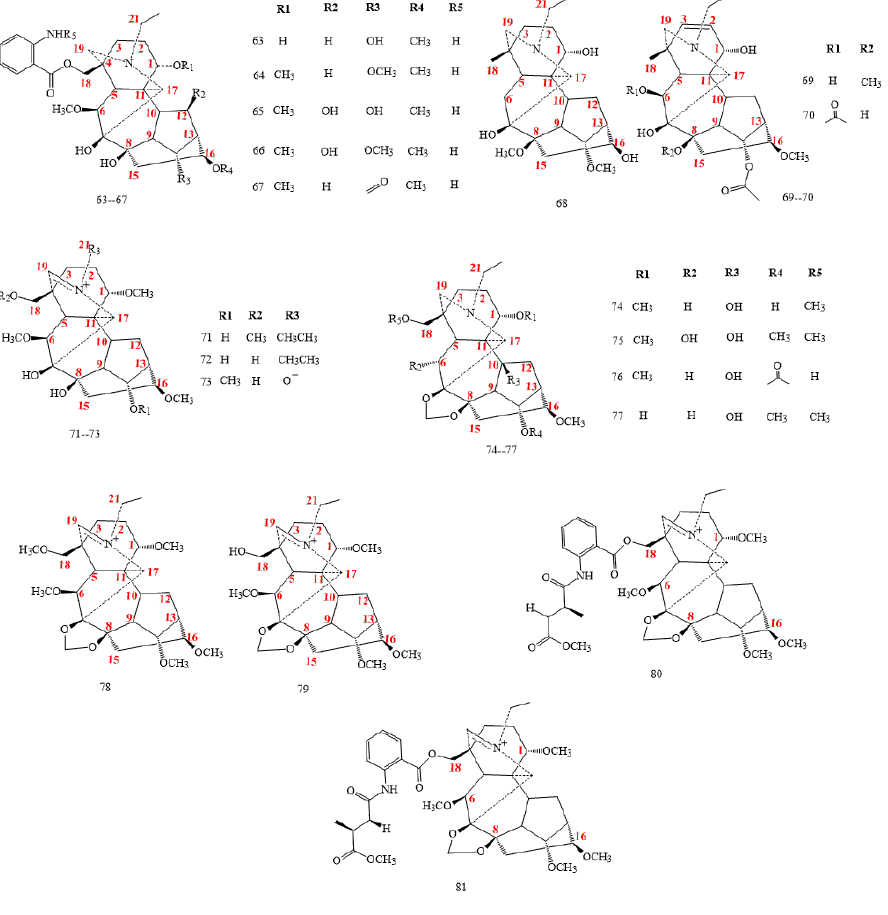
Figure 6. C 19 -lycoctonine DAs.